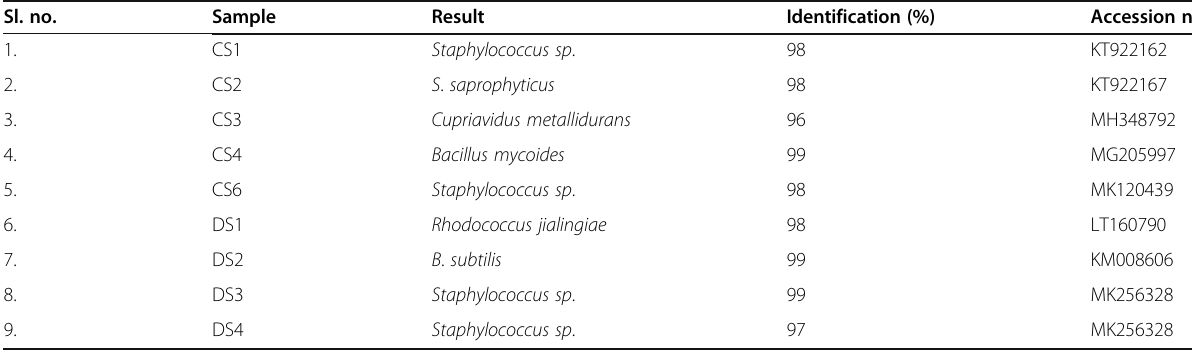
Table 2 Nucleotide nBLAST results of the endophytic isolates Sl.